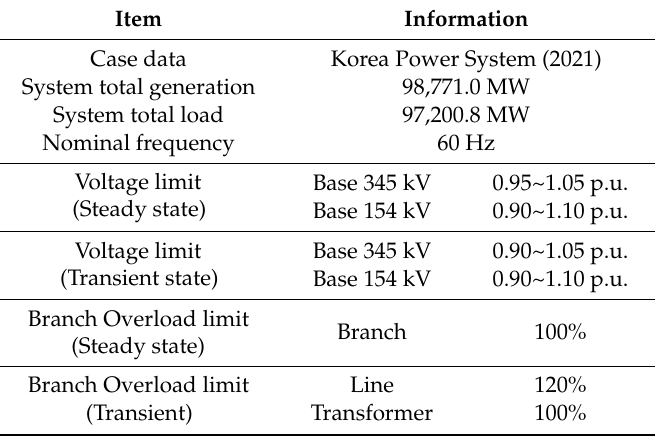
Table 2. System information.